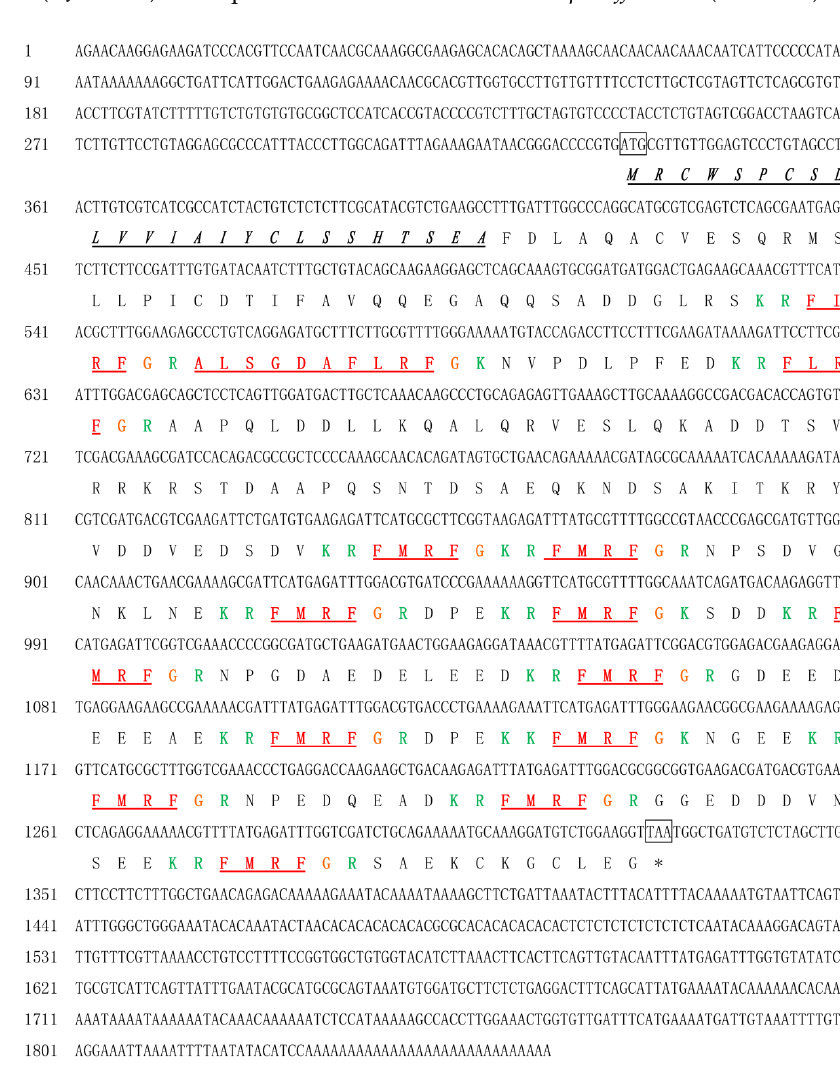
Figure 1. Nucleotide sequence and deduced amino acid sequence of Sp FMRFamide precursor. The initiation codon (ATG) and stop codon (TAA) are marked. The putative signal peptide is underlined in black and italic, and the predicted RFaRPs are marked in red. The basic cleavage sites are identified green color, and the glycines used for C-terminus amidation are marked in